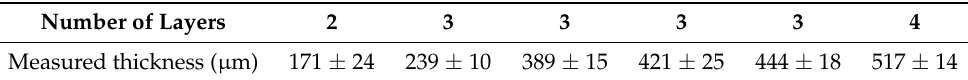
Table 2. Number of layers and the measured thickness by the use of